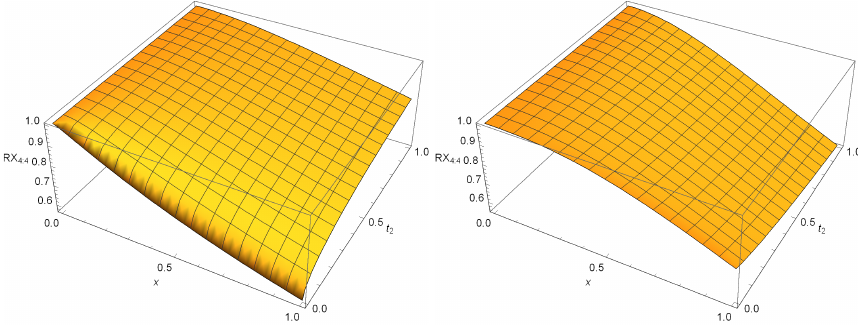
Figure 3. The graphs of the reliability function of RX 4:4 ( t 1 , t 2 ) , for the Weibull ( α = 0.6, λ = 1.1 ) ( left ) and ( α = 1.3, λ = 0.8 ) ( right